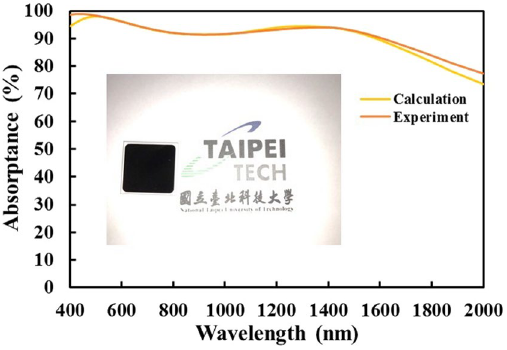
Figure 6. Measured and calculated absorptance spectra of Air/SiO 2 (80 nm)/Cr(6 nm)/SiO 2 (88 nm)/Cr(6 nm)/ SiO